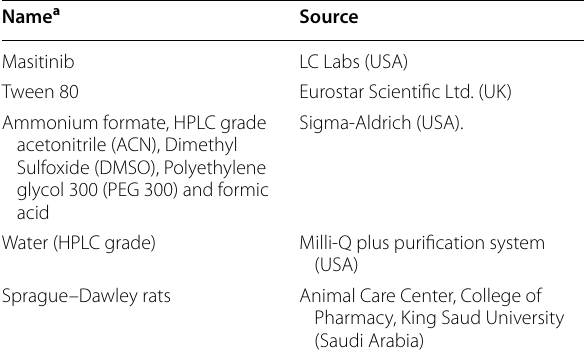
Table 1 List of materials and